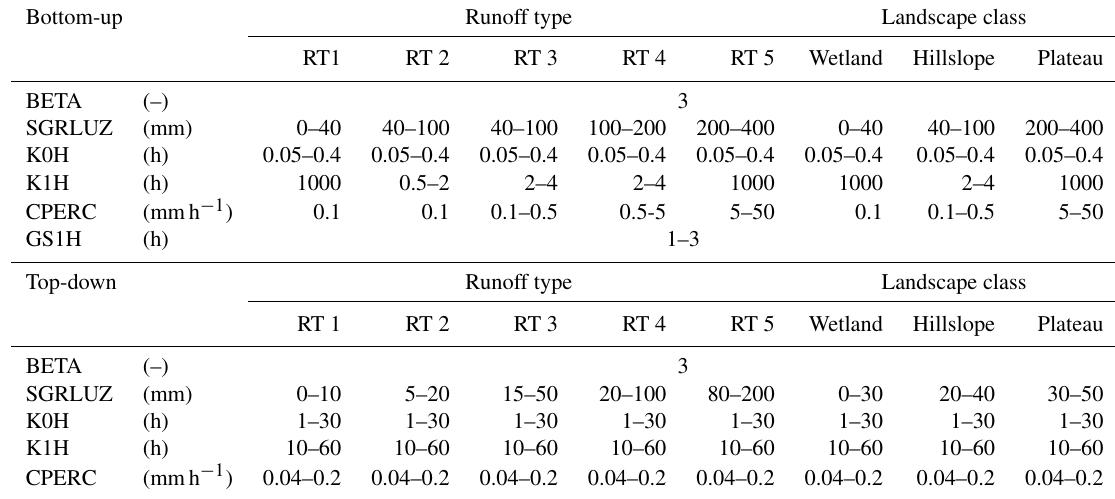
Table 3. Parameter ranges for the bottom-up and top-down model configurations. Bottom-up Runoff